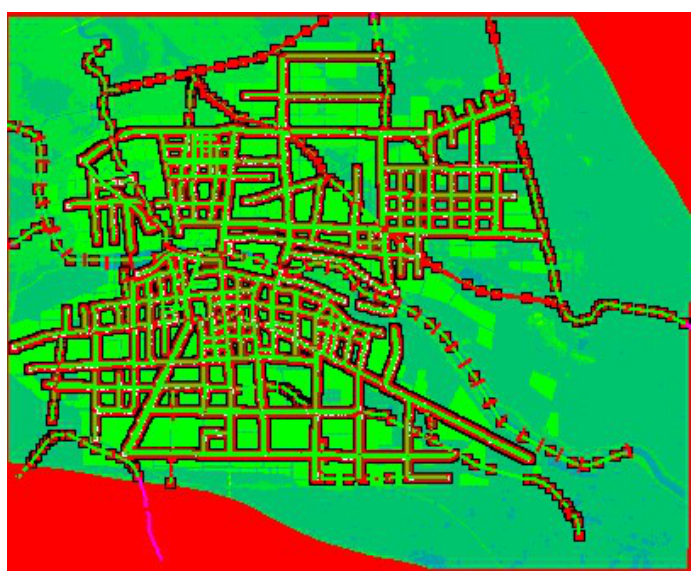
Figure 5. Schematic diagram of the coupling links.